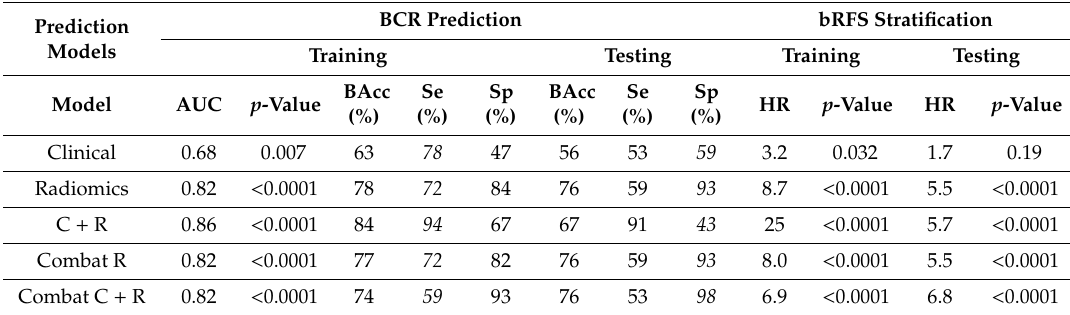
Table 3. Performance of each prediction model according to the